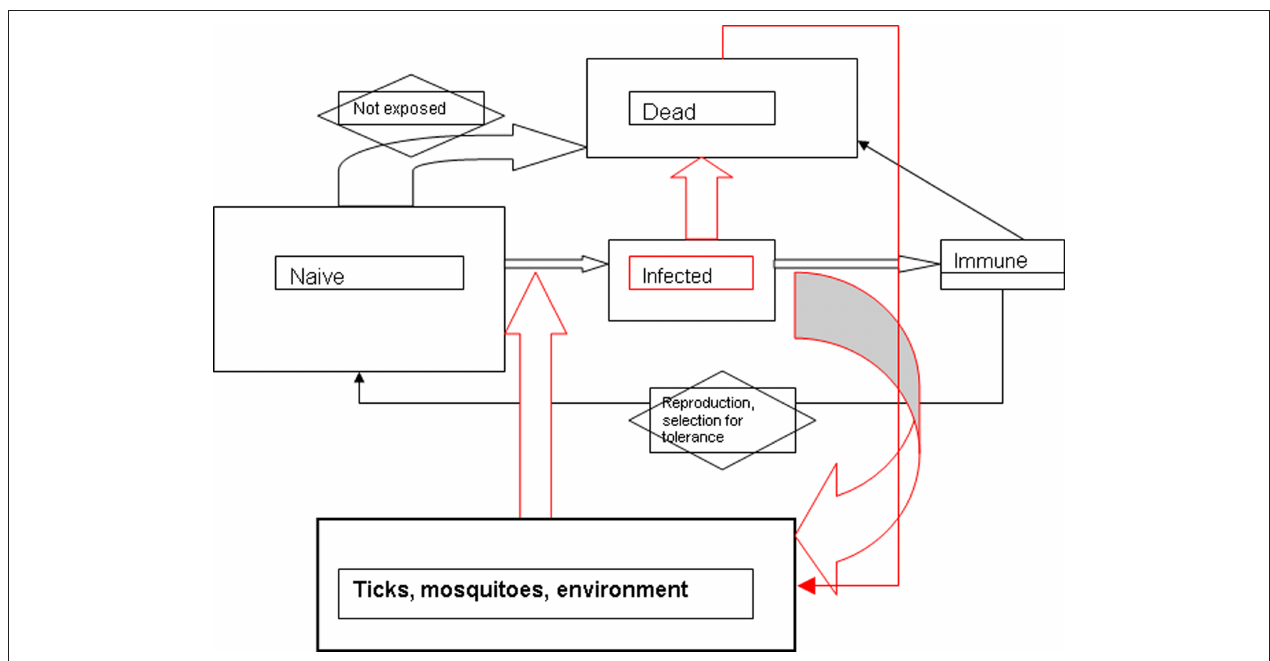
Figure 1 | Flow chart (“compartmental model”) for general model of F. tularensis perpetuation. Rectangles represent hosts; size of rectangle might represent magnitude of host population. Red lines or arrows represent path taken by F. tularensis . Mode of transmission is a black box which comprises multiple factors. No time scale is implied in this simple